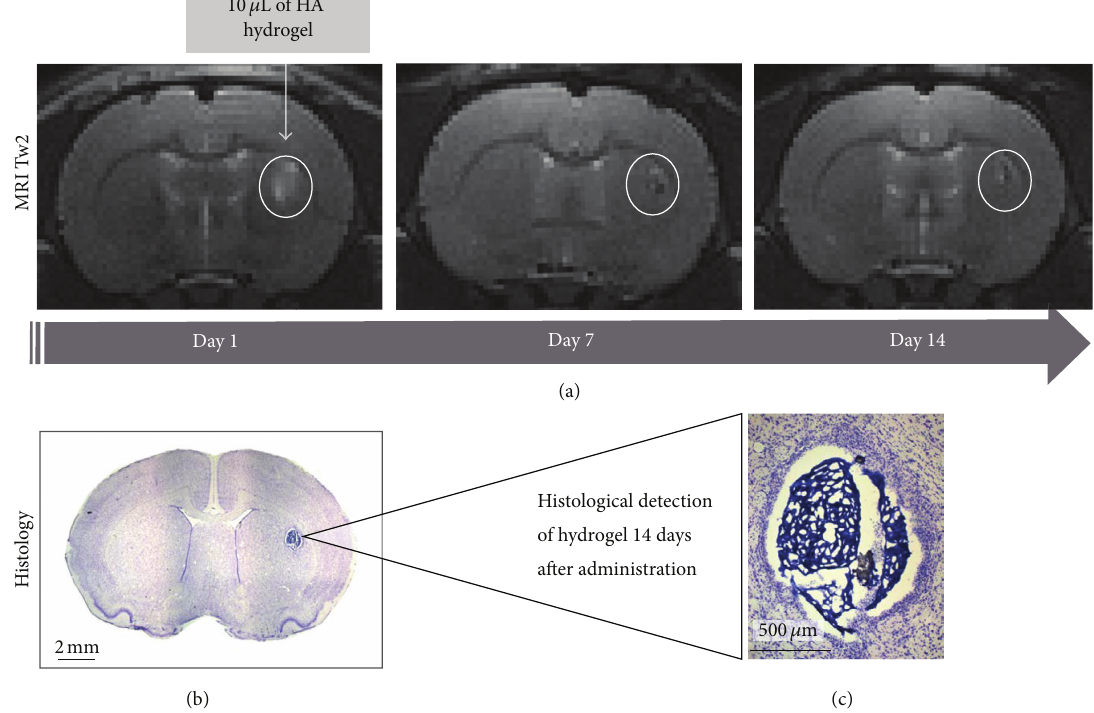
Figure 3: Representative images of in vivo and ex vivo detection of hyaluronan-acid (HA) hydrogel. (a)Magnetic Resonance Imaging (MRI) weighed in T2, hydrogel detected at different time points (days one, seven, and fourteen after administration). (b) Cresyl violet staining of HA hydrogel acquired two weeks after administration, noted in ( × 2) (b) and (c) (x10) magnification. These images demonstrate efficient local gel formation instead of liquid diffusion which would be due to a delayed polymerization after infusion and the in vivo stability of HA